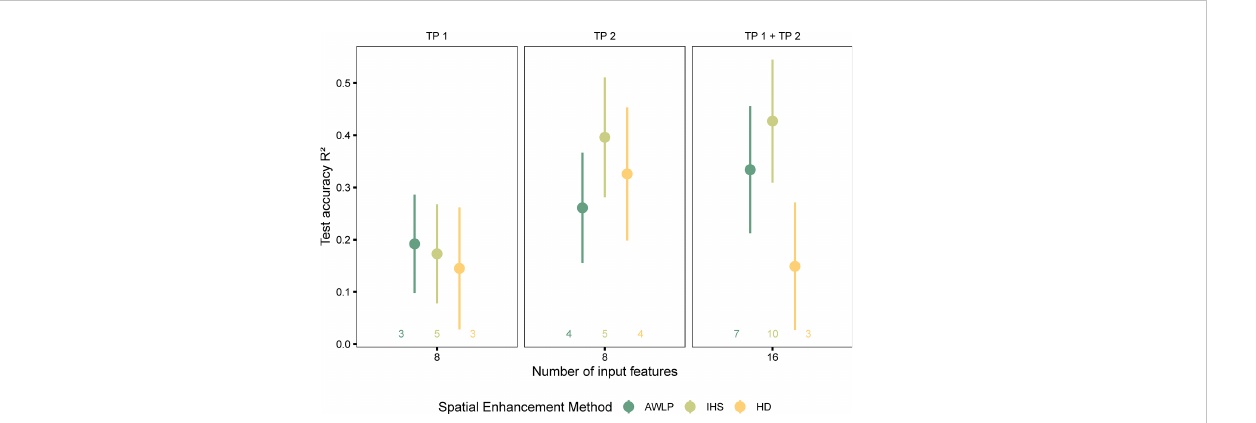
FIGURE 10 Model performance based on spectral data (pan-sharpened imagery developed using integration of satellite and UAS imagery using AWLP and IHS approaches with GSD = 0.15 m), and time points (individual and combined time points). The number of input features represented as labels of the x- axis indicates the number of features before the correlation fi lter. The colored numbers above the x-axis represent the total number of features retained after the correlation fi lter, which were used to build the random forest models.